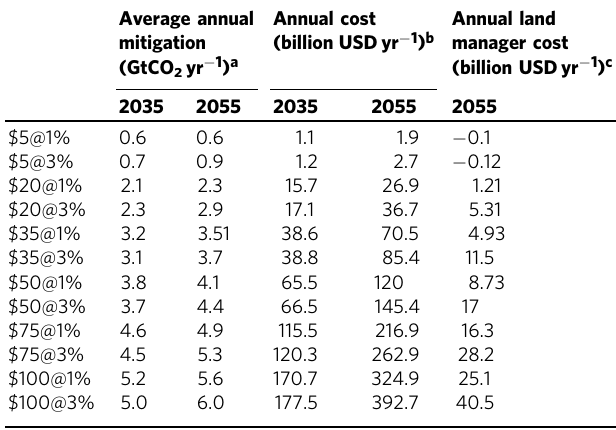
Table 1 Projected average annual forest sector mitigation and costs.